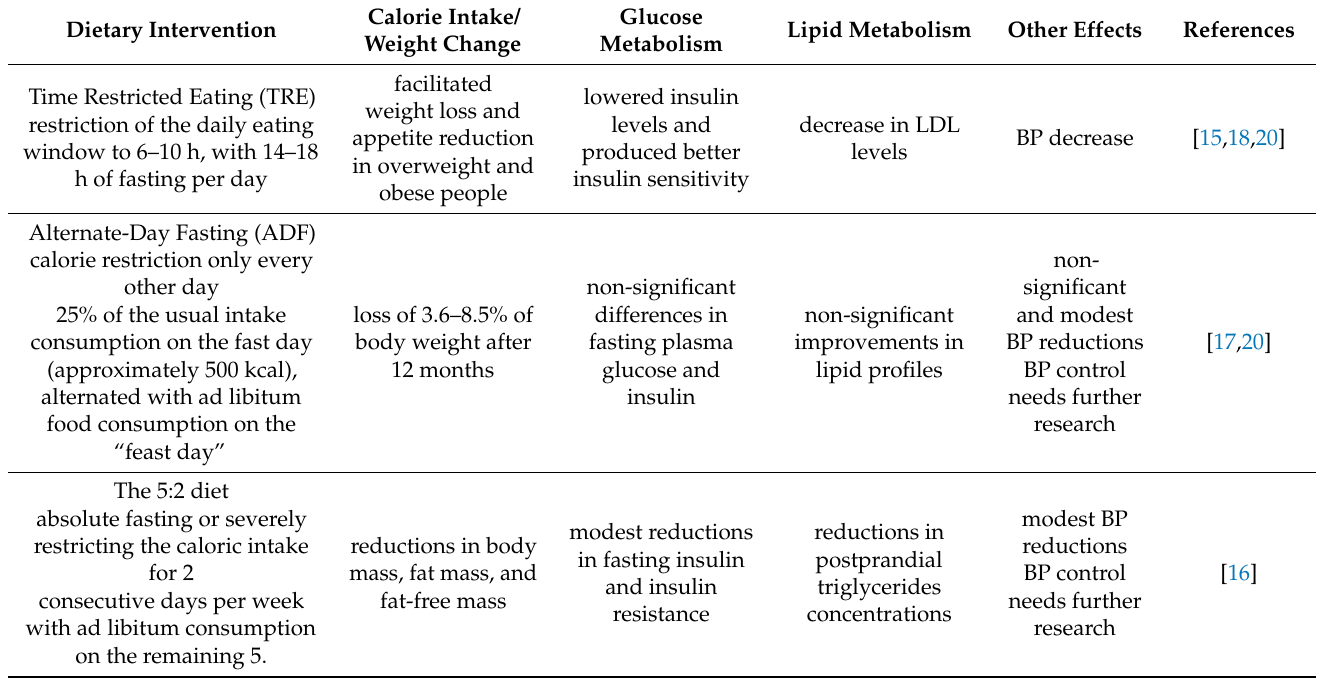
Table 1. Comparative data on potential benefits of intermittent fasting and time-restricted